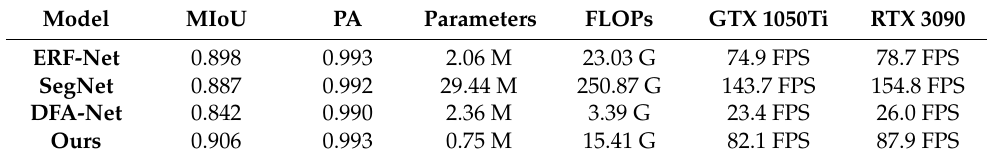
Table 7. Network performance